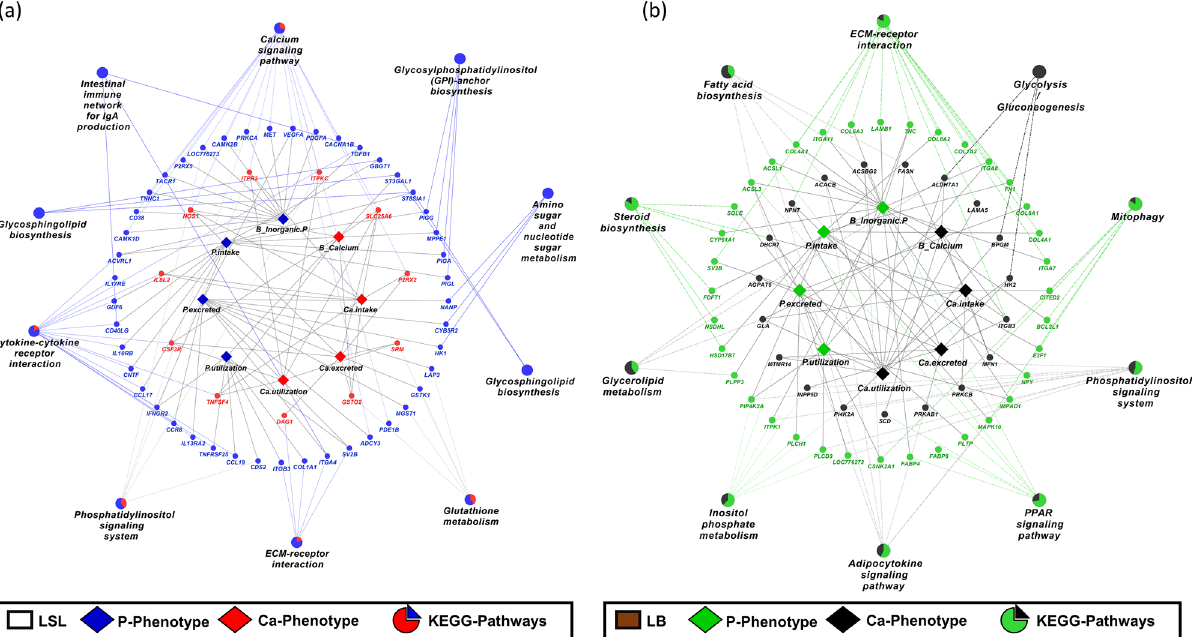
Figure 12. KEGG Pathway analysis of mRNA-phenotype data from different diet groups within LSL and LB strain. ( a ) KEGG pathways enrichment analysis was performed used mRNA which negative correlated with miRNA as showed in Figs. 10 and 11. ClueGO generated functionally clustered KEGG annotation network of correlated phenotype and mRNA data which negative with miRNA from LSL strain. P value was calculated by right-sided hypergeometric tests and Benjamin–Hochberg adjustment was used for multiple test correction. KEGG pathways with a P < 0.05 were considered significant. Blue ellipse shape indicates the genes which related with phosphorus phenotype and red ellipse shape indicates the genes which related with calcium phenotype. ( b ) Similarly, KEGG pathways enrichment analysis was performed for correlated mRNA-phenotype data which negative correlated with miRNA from LB strain. Green ellipse shape indicates the genes which related with phosphorus phenotypes and black ellipse shape indicates the genes which related with calcium